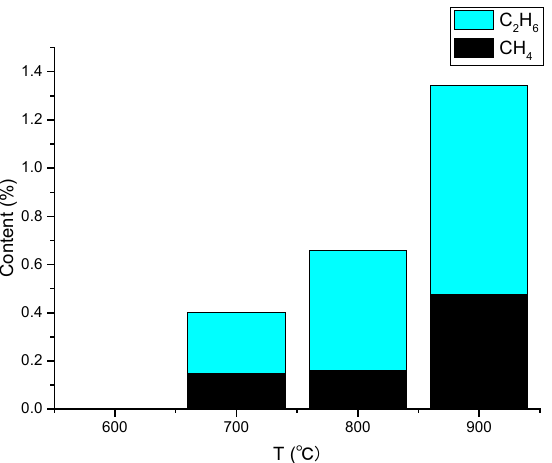
Figure 1. Analysis of the main gas components of graphene growth environment.